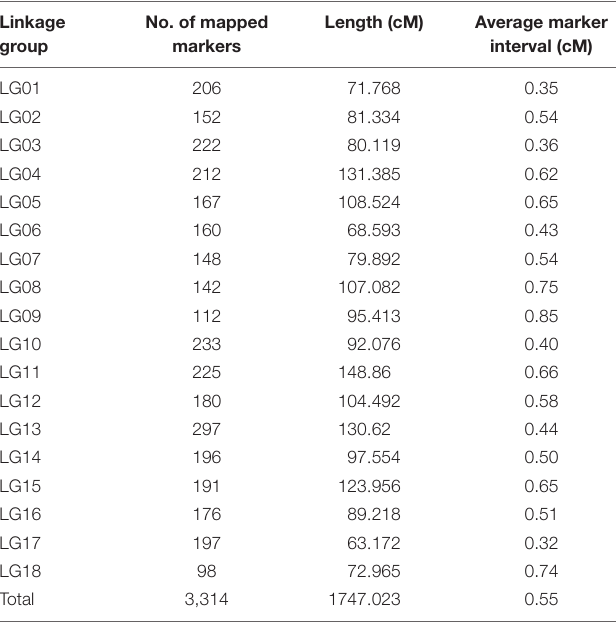
TABLE 6 | Summary of a linkage map for Pacific abalone. Linkage group